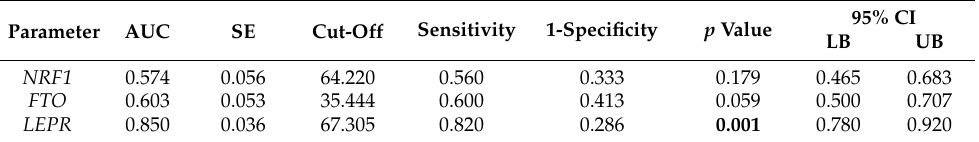
Table 9. ROC curve analysis of methylation of NRF1, FTO, and LEPR with the races shows the relationship between sensitivity and specificity in determining a specific marker.